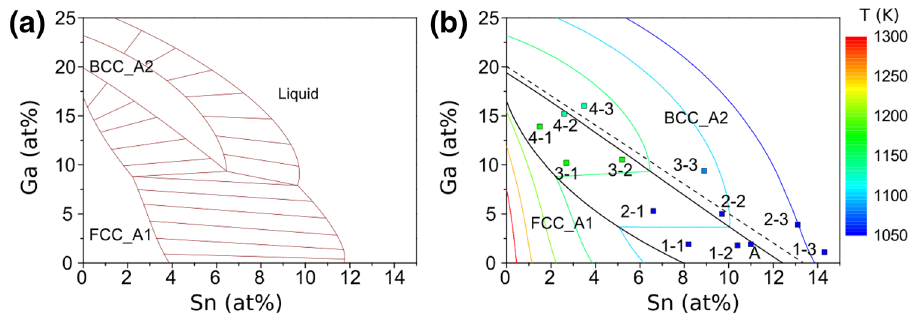
Figure 6. ( a ) Isothermal section at 1150 K, and ( b ) solidus projection calculated with FactSage 34 . Compositions of the DSC samples (1–1 to 4–3) and a bulk Cu-2 at% Ga-11 at% Sn sample (A) are shown with the color filling indicating the measured solidus temperature. Black lines represent univariant equilibria; the dashed line was obtained considering the microstructural transitions from α to δ as shown in Fig.